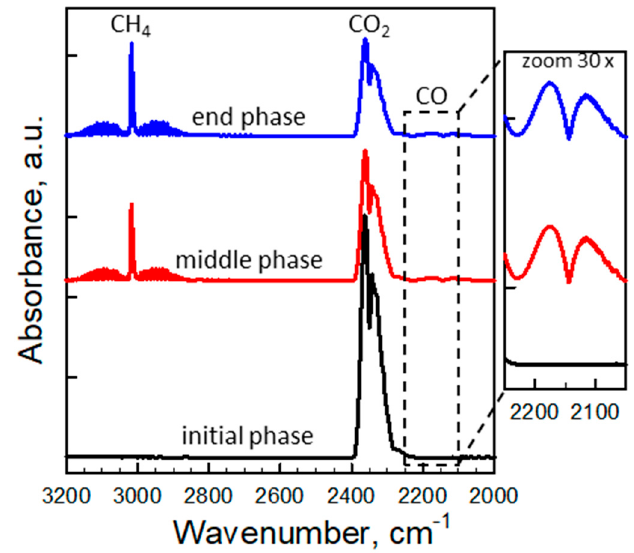
Figure 7. Fourier transform infrared (FTIR) spectra of the evolved gas leaving the TG at three times during the reduction step (under CH 4 flow) of Co-La 2 O 2 SO 4 at 900 ◦ C (7th cycle of Figure 6). The inset shows a magnification (30x) of the region of typical CO absorption bands.